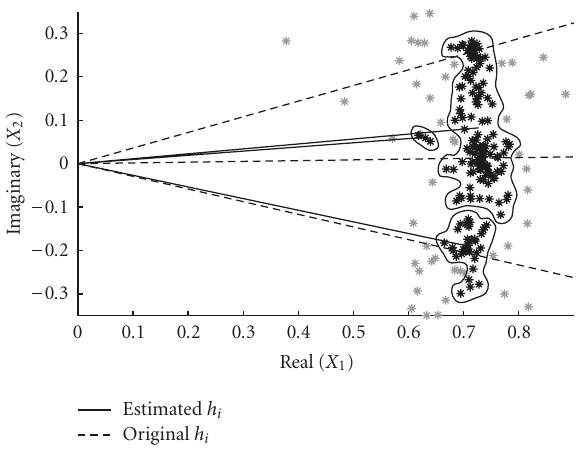
Figure 5: Example of unintentionally combining desired clusters, f = 1164 Hz.